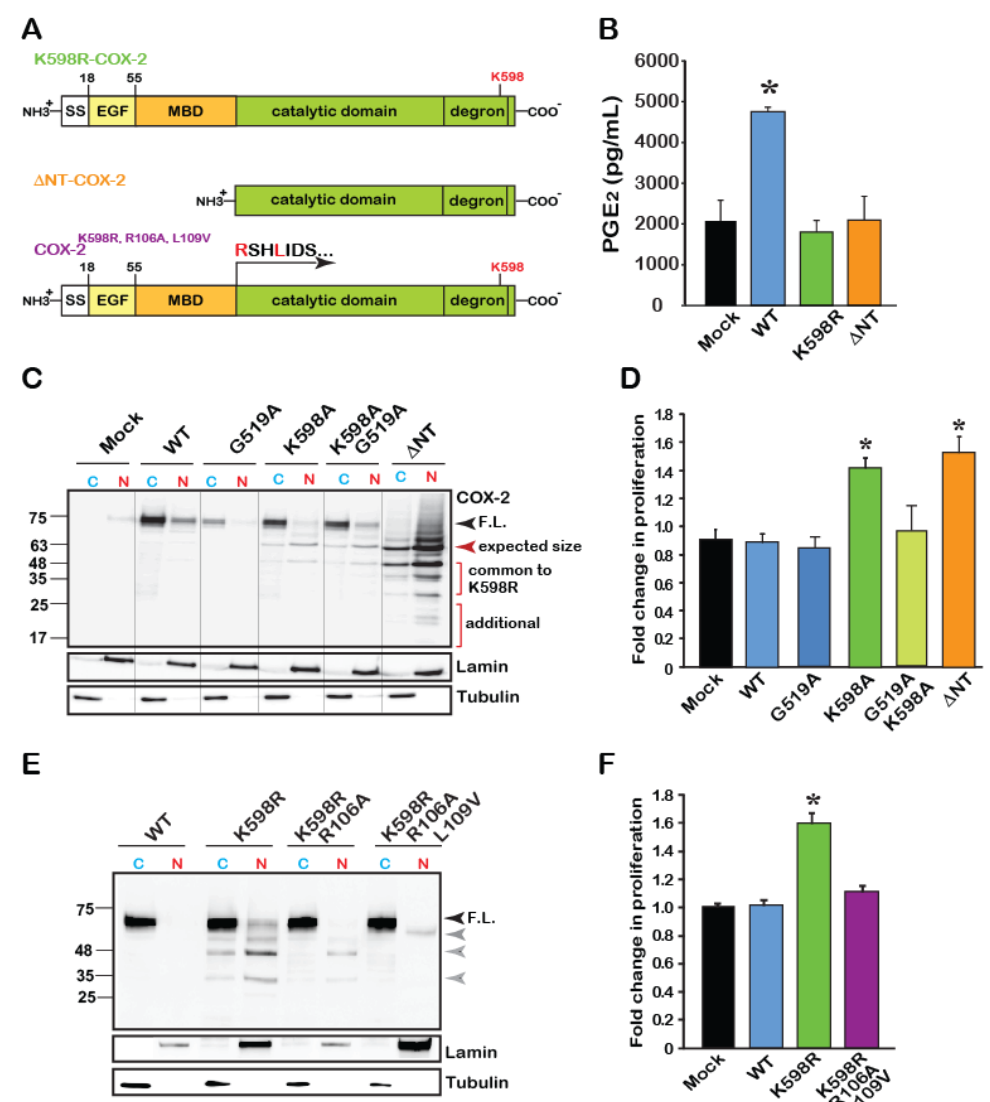
Figure 4. The catalytic region of COX-2 enhances cell proliferation independent of enzymatic activity. ( A ) Schematic domain structure of COX-2 and its various mutants. According to the crystal structure of COX-2, the catalytic domain begins at amino acid 110. ( B ) Measurements of WT and mutant COX-2 enzymatic activity by assessing the production of PGE 2 . Only WT COX-2 has enzymatic activity, while K598R- and ΔNT-COX-2 do not. ( C ) Representative immunoblot of Cytosolic (C) and Nuclear (N) fractions of HEK 293 cells expressing Mock transfected, WT, catalytically inactive G519A COX-2, K598R, K598A/G519 and ΔNT-COX-2. F.L. marks the full-length protein of 72 kD. COX-2 mutants contacting K598R mutations present lower MW immunoreactive bands that are mainly localized to the nucleus. A similar pattern is observed with ΔNT-COX-2, which seems to be further cleaved. ( D ) Effect of COX-2 mutants G519A, K598, G519A/K598A, and ∆ NT-COX-2 on cell proliferation measured by XTT ( n = 5 in triplicates, One-way ANOVA * p < 0.001vs. mock transfection). ( E ) Representative immunoblot of cytosolic (C) and nuclear (N) fractions of cells expressing WT, K598R, K598R / R106A or K598R / R106A / L109V COX-2. Mutations at the MBD-catalytic domain of K598R COX-2 cause a significant reduction in the appearance of lower COX-2 immunoreactive bands. ( F ) Mutations at the MBD-catalytic domain interface abolish the proliferative e ff ect of K598R COX-2 as measured by XTT, 36 h post-transfection ( n = 4 in triplicates, One-way ANOVA * p < 0.001vs. mock